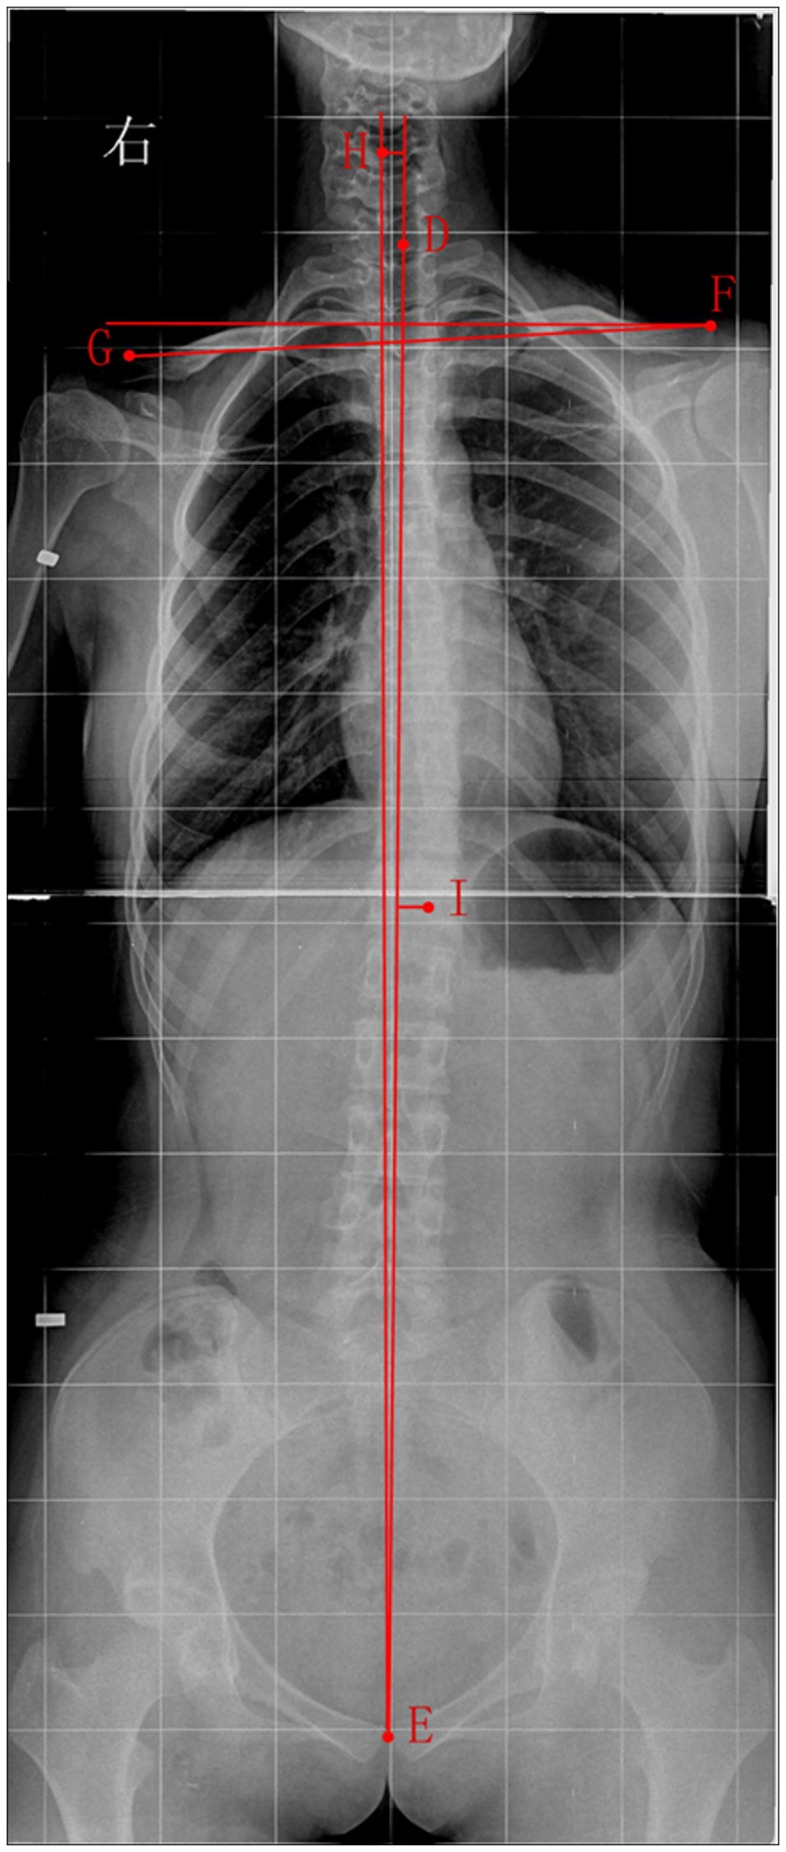
Standing anteroposterior X-ray film of the full-length spine.The midpoint of the 7th cervical vertebra was designated as point D, the midpoint of pubic symphysis point E, and the shoulder peaks as points F and G. In the cervical and thoracic vertebrae, the midpoints of the upper most scoliotic vertebra were designated as points H and I.